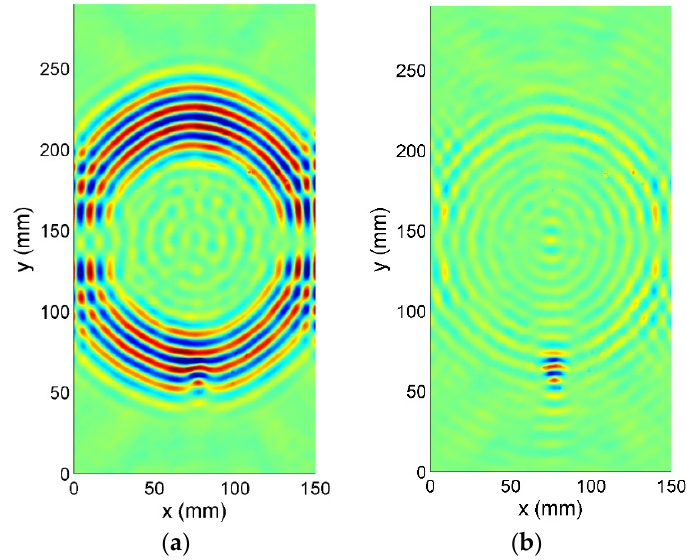
Figure 7. Wavefield image captured at time moment t 1 in the space-space domain: ( a ) without processing; ( b ) after adaptive filtering.